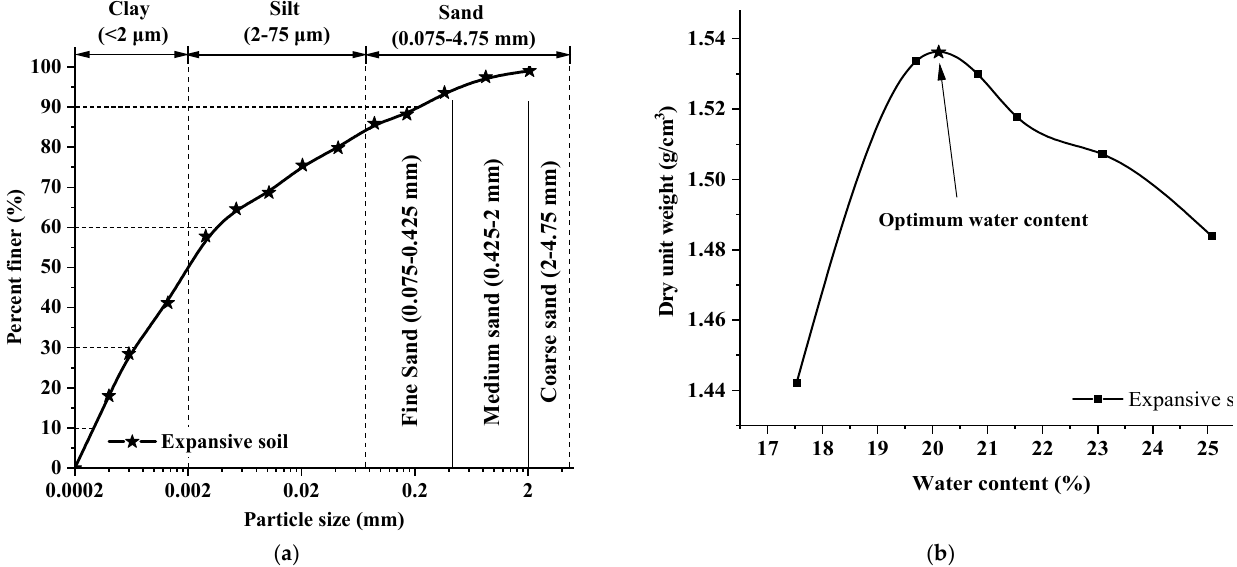
Figure 1. Grain-size distribution curves and compaction test for the soil. ( a ) Ratio and classification of different soil particles; ( b ) compaction curves of the soil. Table 1. Physical properties of the selected expansive soil.